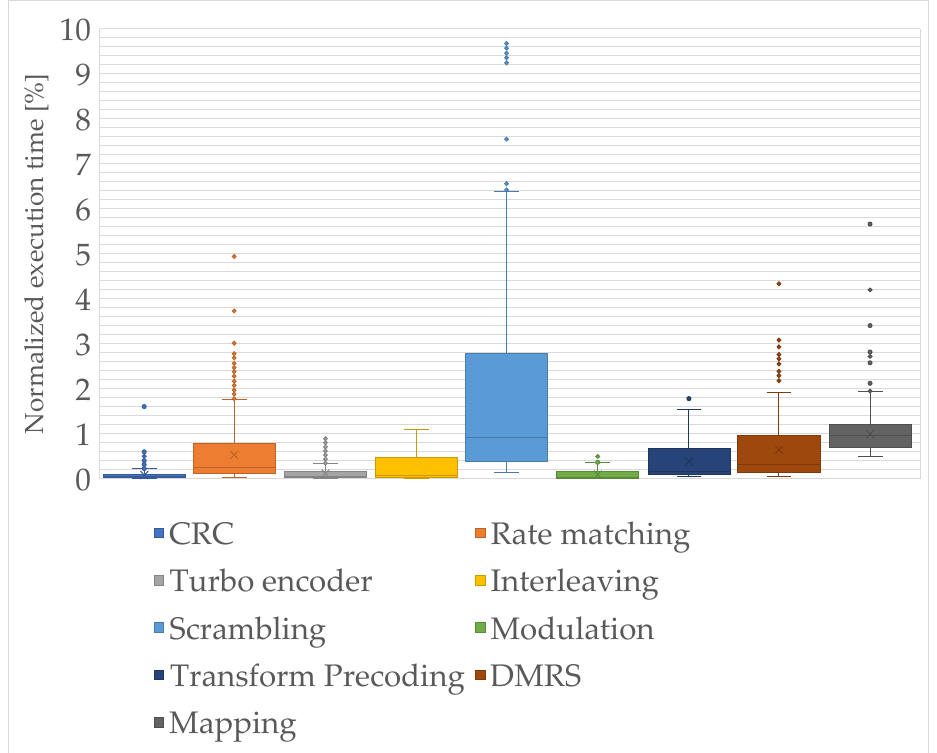
Figure 8. Normalized execution time of modules in the block chain between CRC and mapping to physical